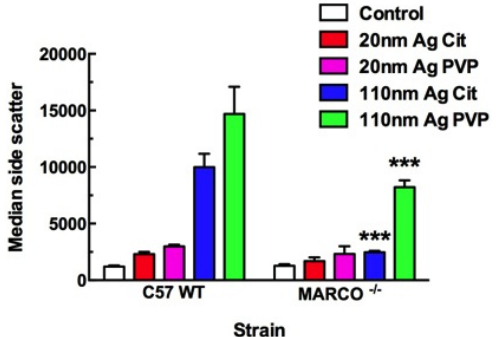
Figure 3. Ag uptake at 1 h in murine AM cells using side scatter measured by flow cytometry. C57BL/6 and MARCO null AM were exposed to Ag particles in suspension culture for 1 h. All data expressed as mean ± SEM. Asterisks indicate significance at *** p < 0.001 compared corresponding particle exposure condition by post hoc mean